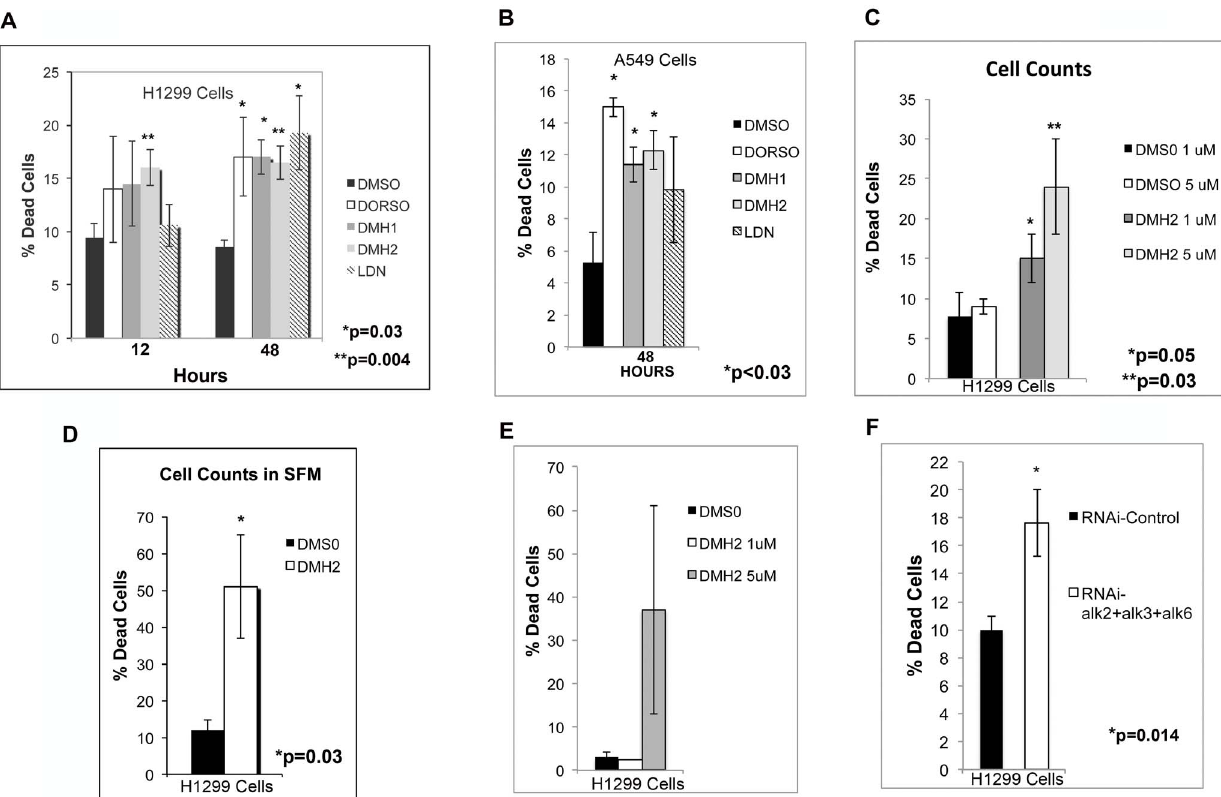
Figure 5. Inhibition of type I BMP receptors in lung cancer cell lines induces cell death. ( A–B ) H1299 and A549 cultured in DMEM 5% FCS were treated with DMSO or a BMP receptor antagonist (10 m M Dorsomorphin or 1 m M of selective antagonist). The percentage of cells that take up ethidium bromide was then determined. The data is reported as the mean of at least 3 independent experiments. ( C ) H1299 cells cultured in DMEM 5% FCS were treated with DMSO, 1 m M and m 5 M of DMH2 for 7 days, stained with Typan Blue, and cell counts performed. Data represents the